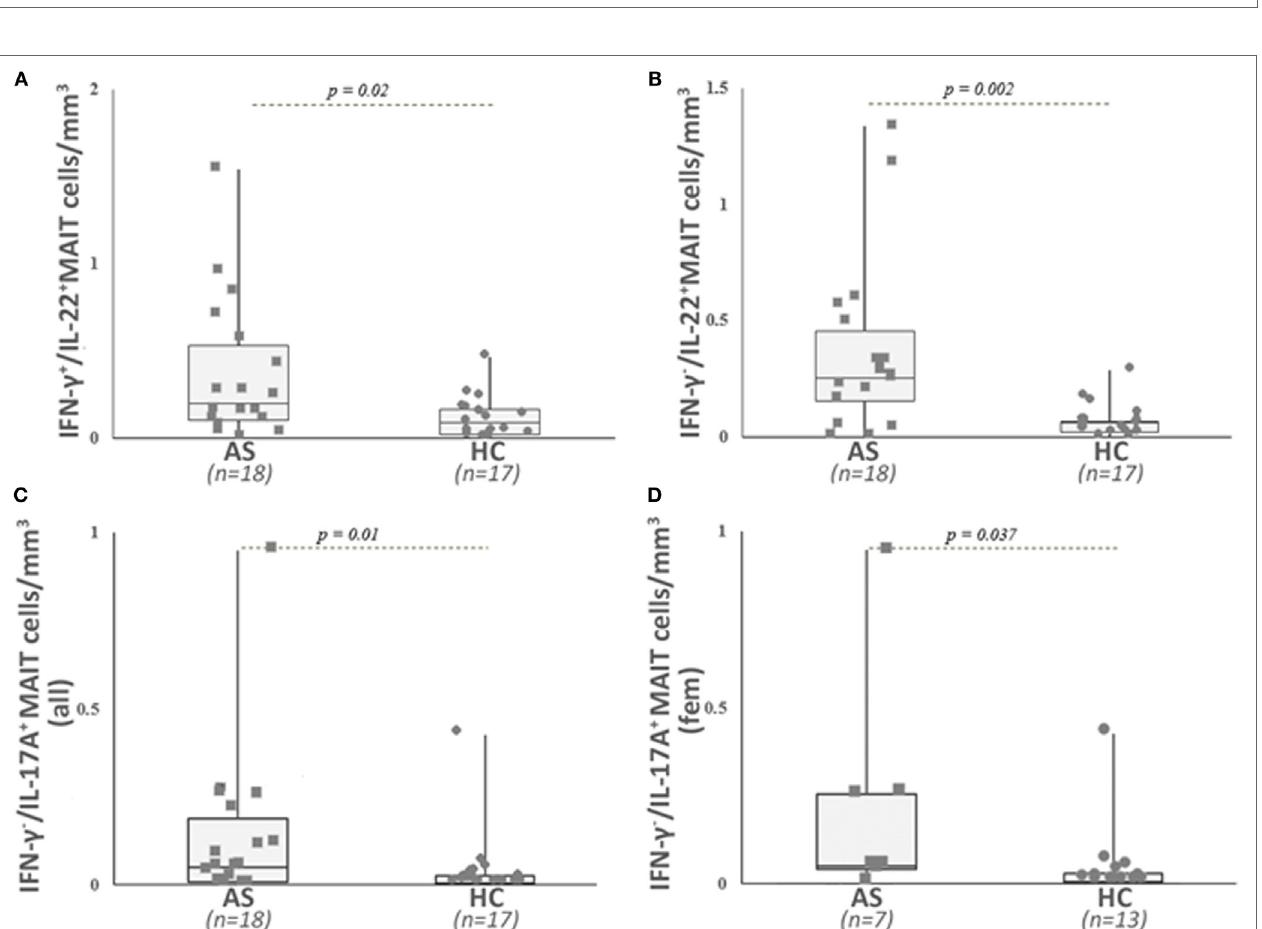
FigUre 4 | Analysis of different cytokine-secreting mucosal-associated invariant T (MAIT) cells in patients with ankylosing spondylitis (AS) and in healthy controls (HC). Circulating cytokine-secreting mucosal-associated invariant T (MAIT) cells were analyzed as described in Section “Patients and Methods” and gated as described in Figure 2 . Absolute numbers (cells/mm 3 ) were obtained by multiplying the percentages of these cytokine-secreting MAIT cells by the total T lymphocyte number. AS patients exhibited a significant higher number of IL-22- and IFN- γ -secreting MAIT cells (a) , IFN- γ -negative IL-22-positive MAIT cells (B) , and IFN- γ negative IL-17A-positive MAIT cells (c) than HC. IFN- γ -negative IL-17A-positive MAIT cell counts are found increased only in female AS patients when compared with healthy women (D) . Data are depicted as box plots (the band inside the box corresponds to the median). Each symbol represents an AS patient (squares, n = 18 or 7) or HC (circles, n = 17 or 13).